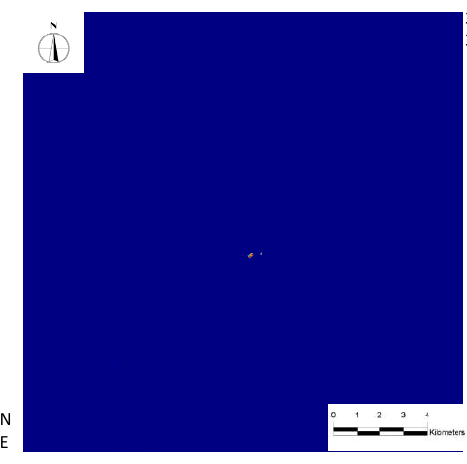
Figure 5. dNBR map calculated by Landsat OLS8 in blue no value in red the maximum index value of ongoing fire